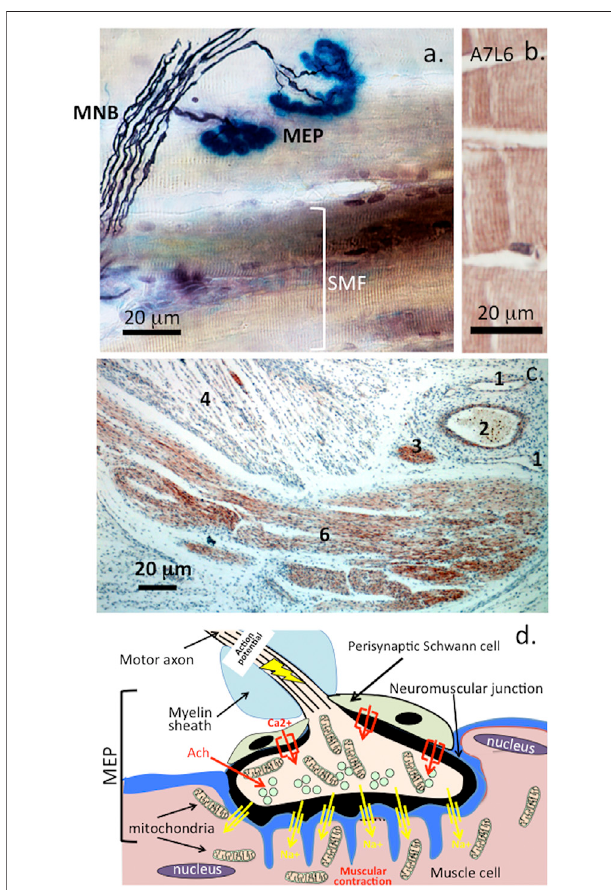
(MEP) and striated muscle fi bres (SMF) (A) . and perlecan-positive striated muscle fi bres stained with MAb A7L6 to perlecan domain IV in